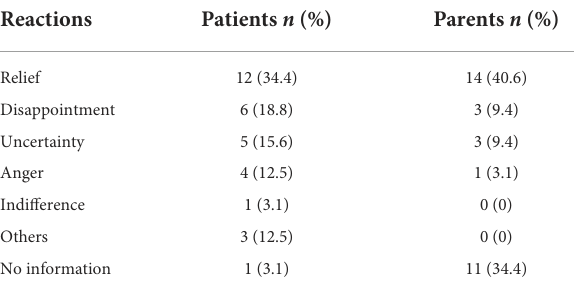
TABLE 3 Reactions of patients ( n = 32) and parents ( n = 16) after having received the diagnosis of MSMI-FTB.